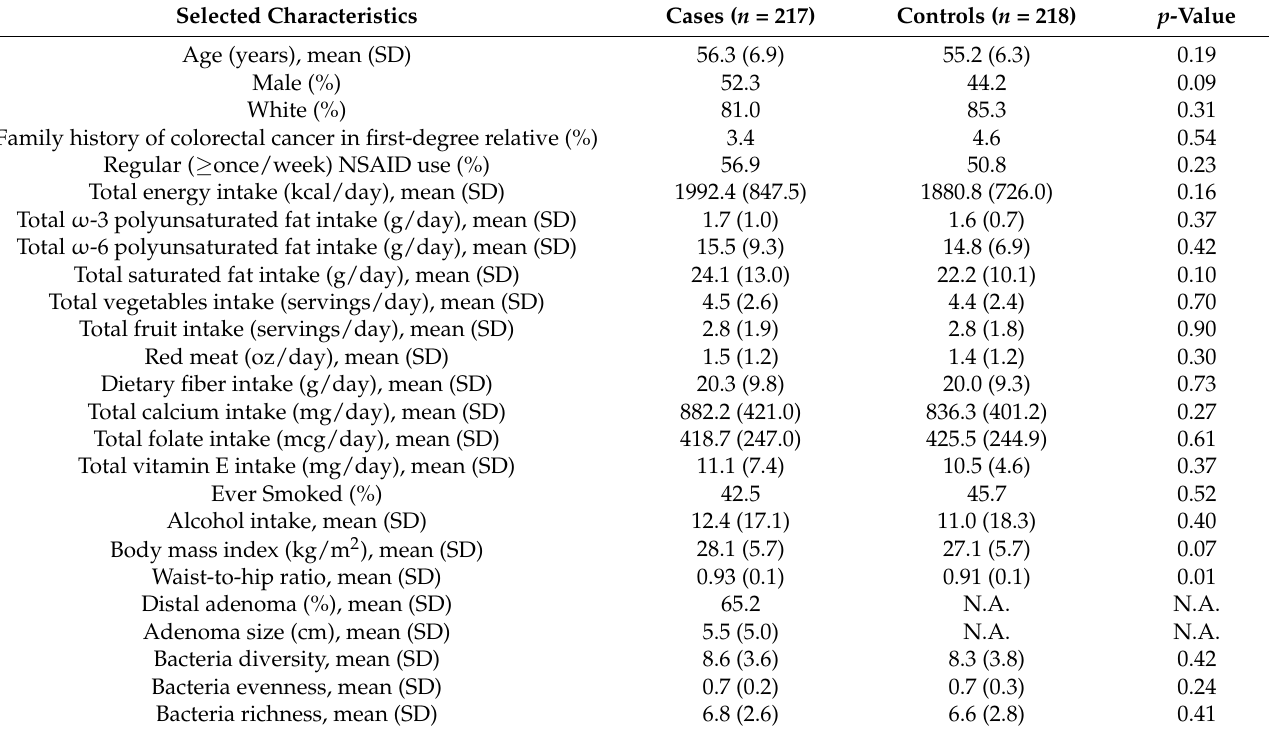
Table 1. Descriptive characteristics of the study participants, Diet and Health Study V, 2008–2010 ( n =